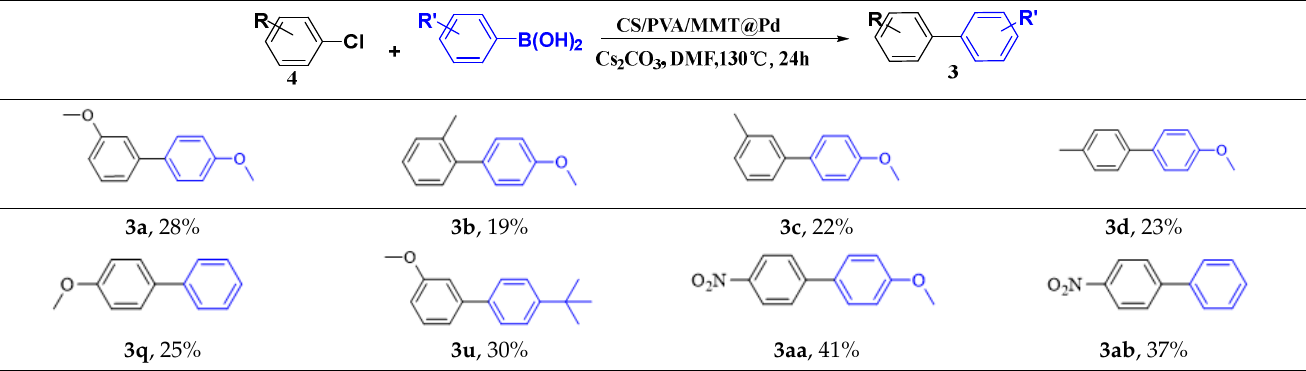
Table 4. Chlorobenzene substrate expansion of Suzuki reaction.